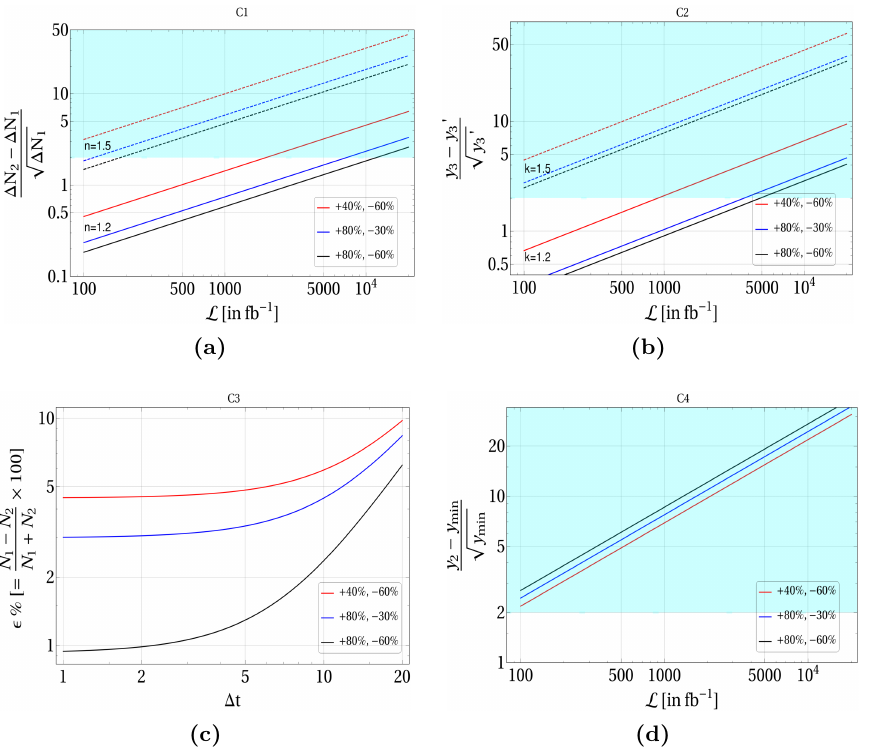
: e − : 0 . 8 , P : − 0 . 6 } . (a) e + e − . C 4